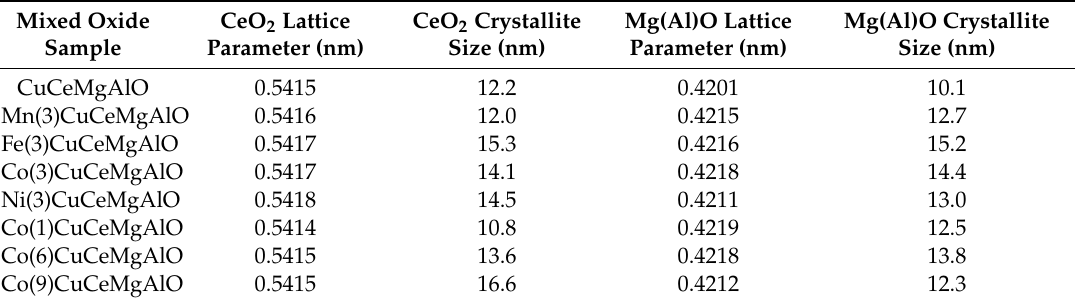
Figure 2. XRD patterns of ( a ) M(3)CuCeMgAlO and ( b ) Co(x)CuCeMgAlO mixed oxides calcined at 750 °C. Symbols: ↓ —CuO tenorite phase. ♦ —CeO 2 fluorite phase. —Periclase-like Mg(Al)O mixed oxide phase. Table 2. Crystallographic data of the LDH-derived mixed